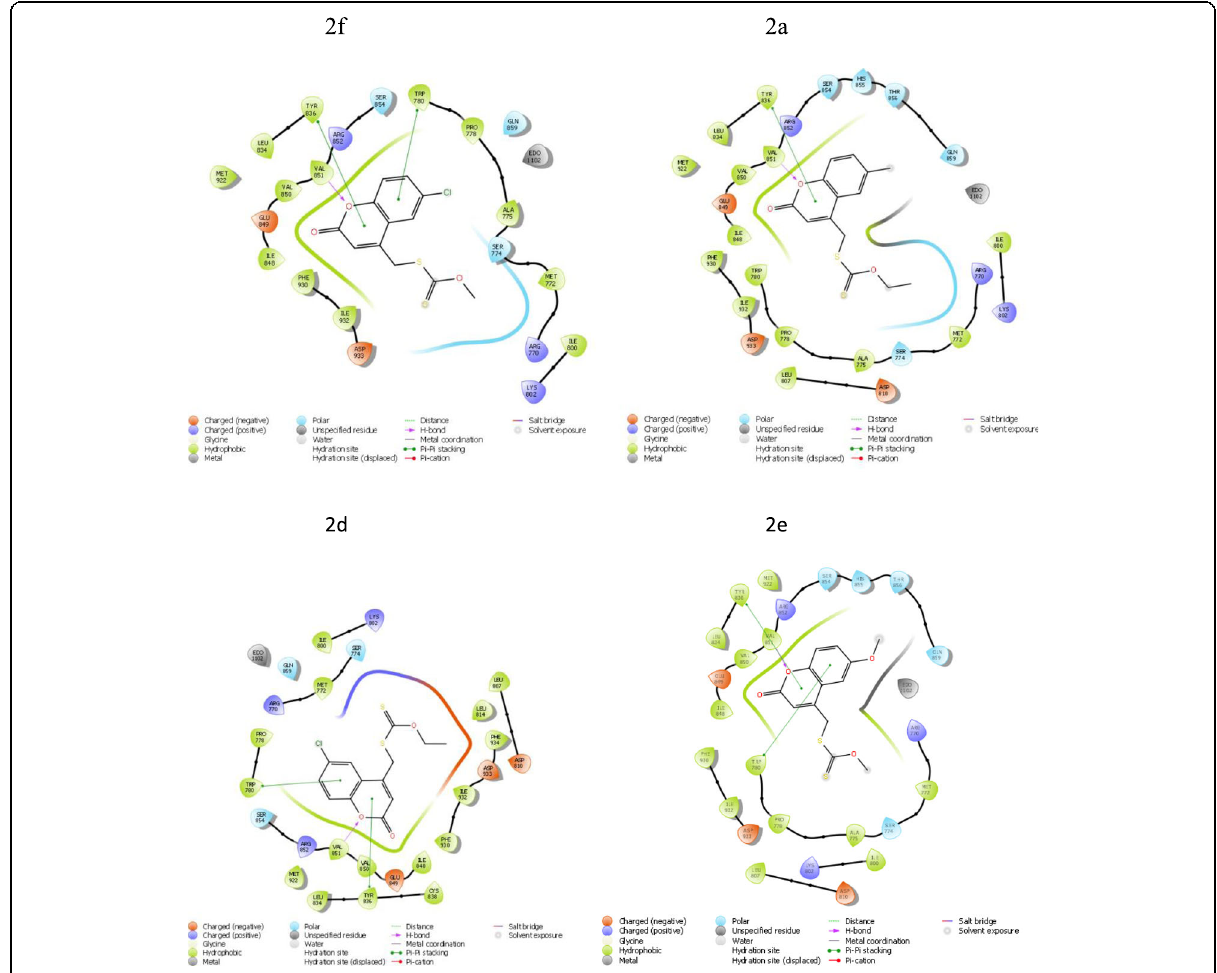
Fig. 6 2D diagrams of interaction of 2f, 2a, 2d, and 2e with PIK3C α protein